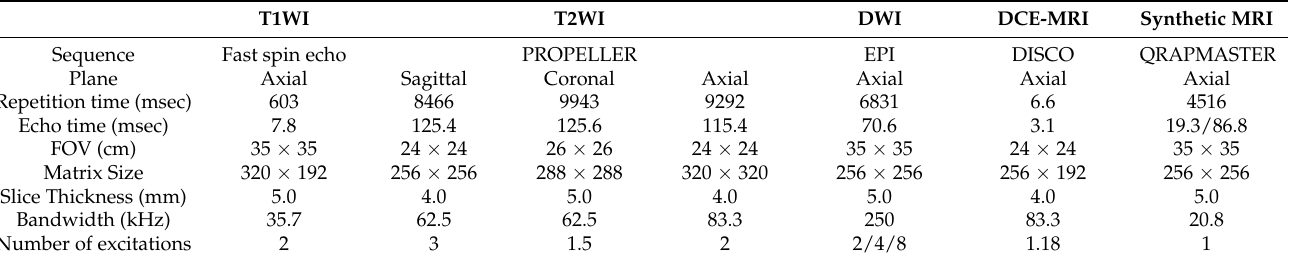
Figure 1. Flowchart of patient recruitment. Table 1. MRI Protocols for conventional MRI and synthetic MRI.